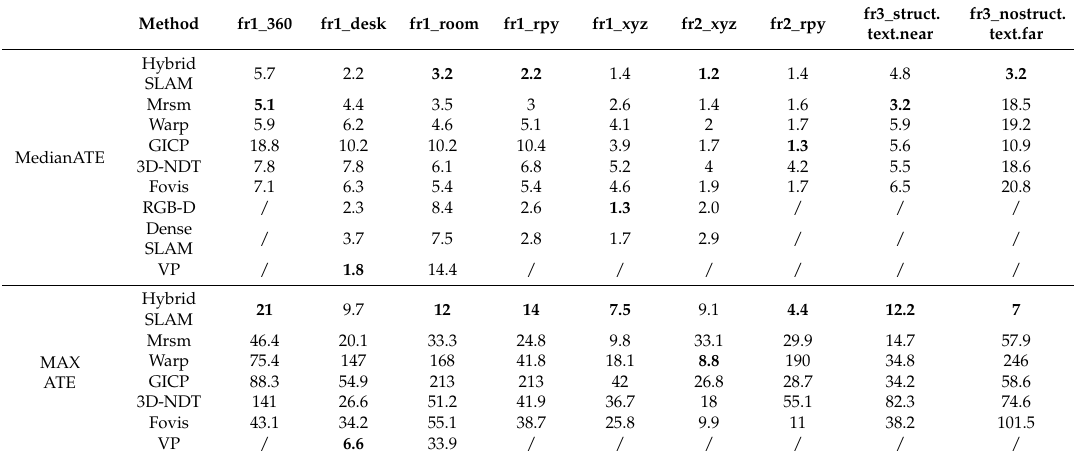
Table 1. Comparisons of the median (max) absolute trajectory error (ATE; in mm) for incremental registration of RGB-D sequences of the Freiburg Benchmark Dataset. Best results in